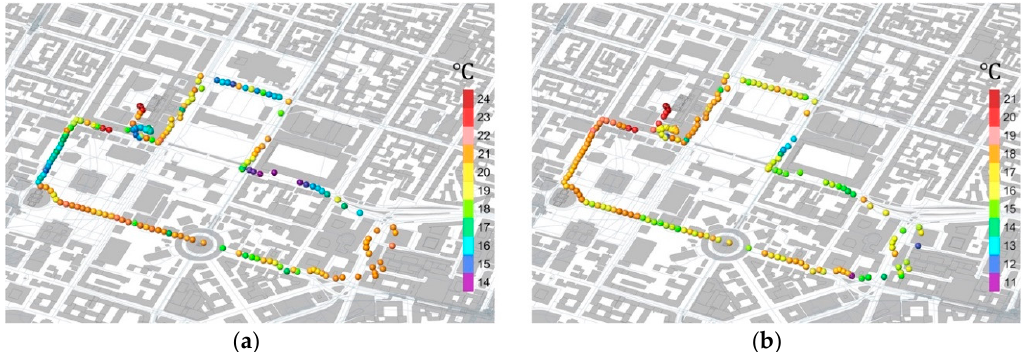
Figure 28. ( a ) Solar radiation (w/m 2 ); ( b ) noise level maps (dB).